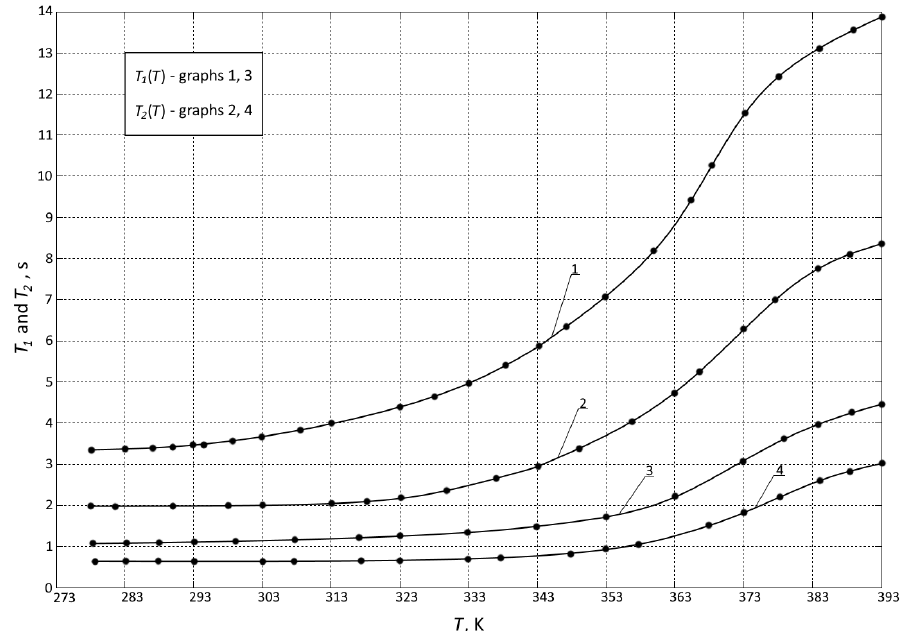
Figure 1. Changes in the longitudinal T 1 and transverse T 2 relaxation times versus temperature T . Graphs 1 and 2 correspond to the values of T 1 and T 2 for distilled water, and graphs 3 and 4 correspond to the values of T 1 and T 2 of an aqueous solution (H 2 O + H 3 BO 3 ) with plutonium nitride filling.